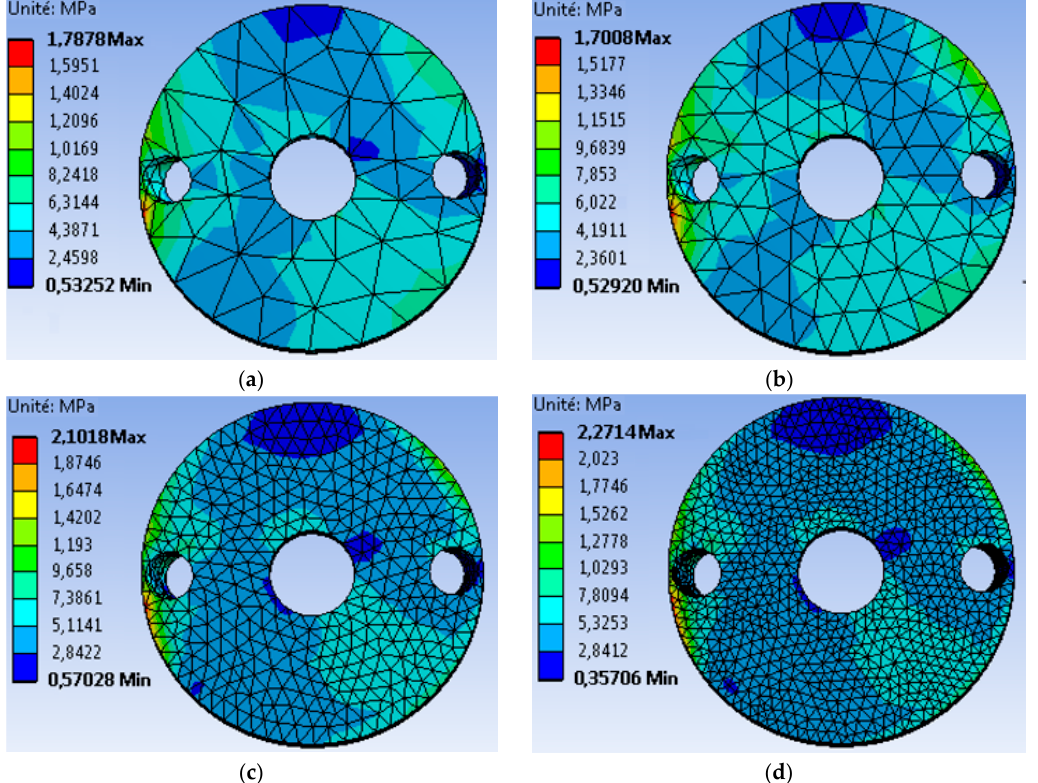
Figure 7. The distribution of Von Mises stresses on the bone graft for different meshes. Mesh ( a ): coarse; Mesh ( b ): medium; Mesh ( c ): fine; Mesh ( d ): very fine.